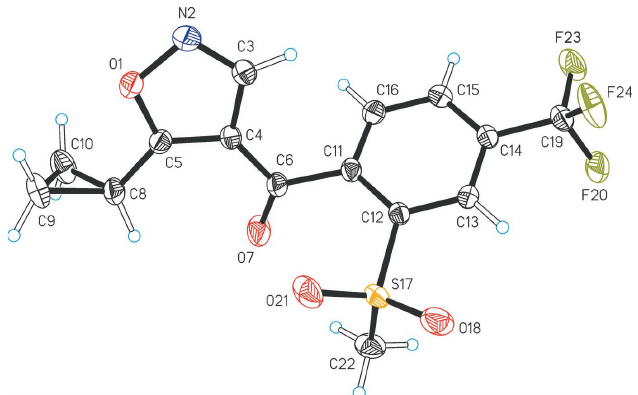
Figure 1 Molecular structure of (I) with displacement ellipsoids drawn at the 50% probability level and hydrogen atoms drawn as spheres of arbitrary